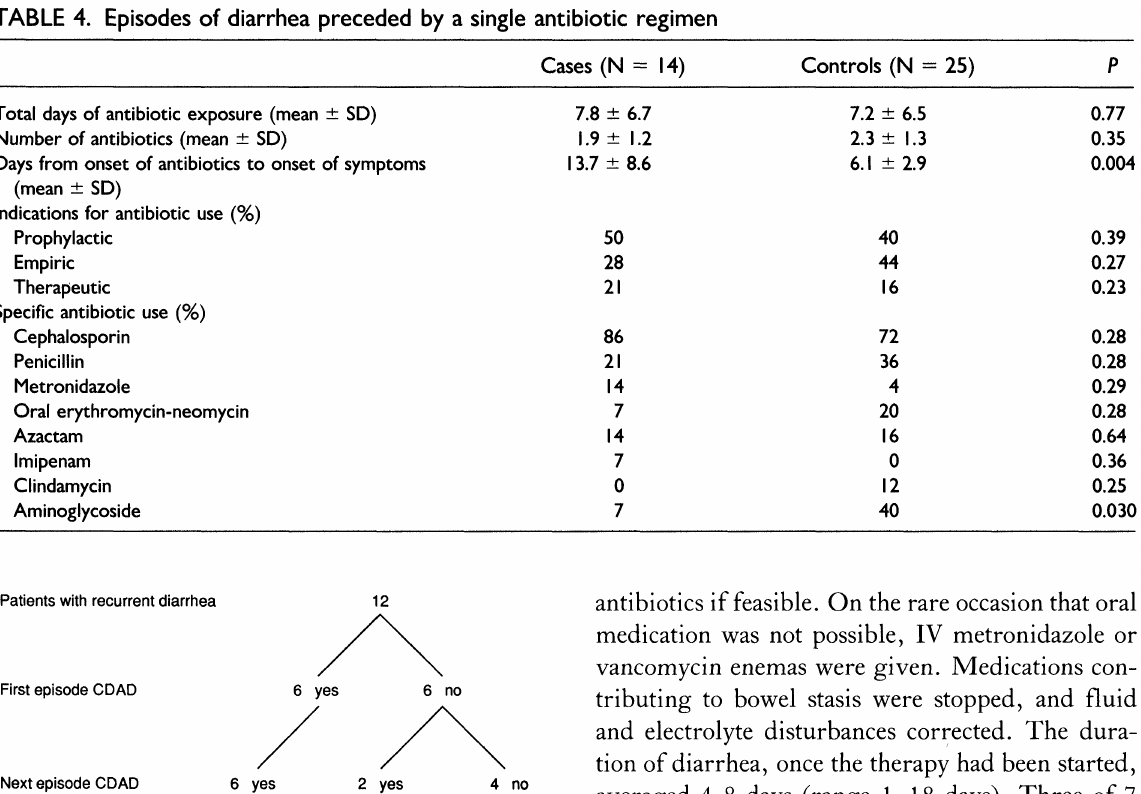
TABLE 4. Episodes of diarrhea preceded by a single antibiotic regimen